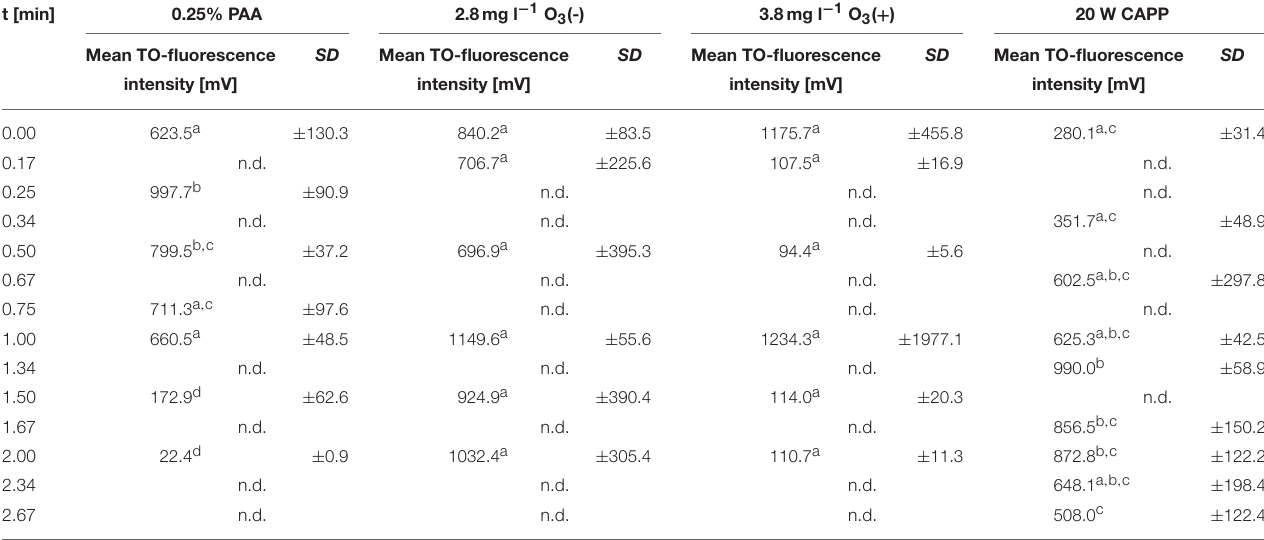
TABLE 2 | Mean TO-fluorescence intensity of P. carotovorum after different treatments. t